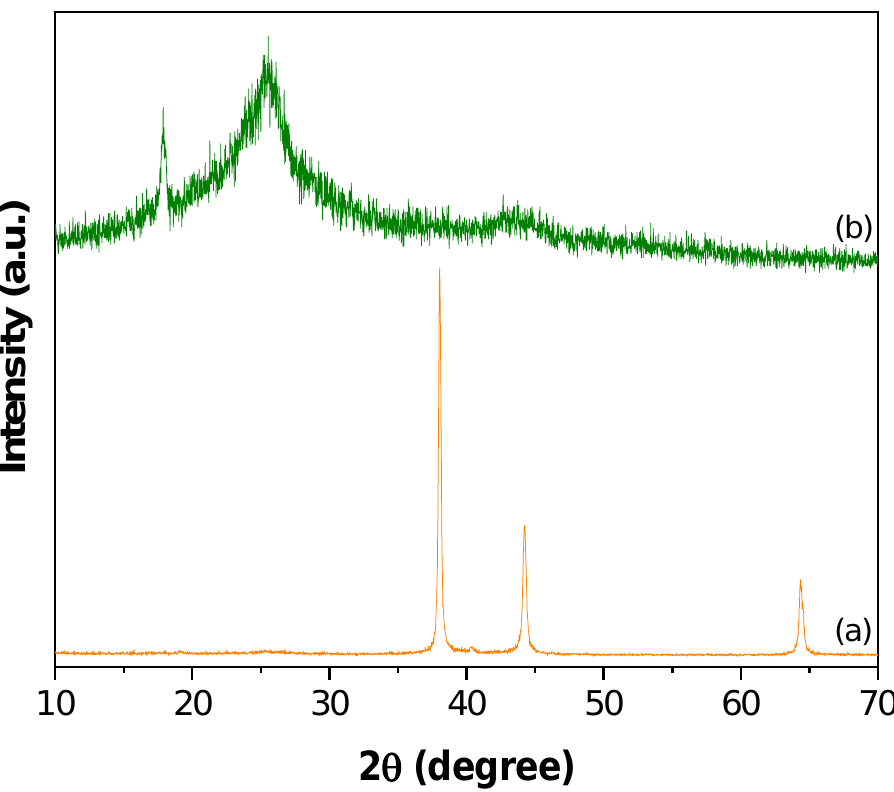
Figure 2. XRD pattern of ( a ) CNTs – PAMAM – Ag and ( b ) CNTs – PAMAM.